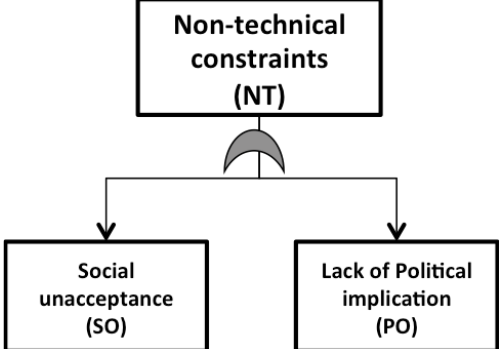
Figure 3. Simplified illustrative case for non-technical constraints involving only sociopolitical constraints. The symbol below the up- per event represents an “OR”